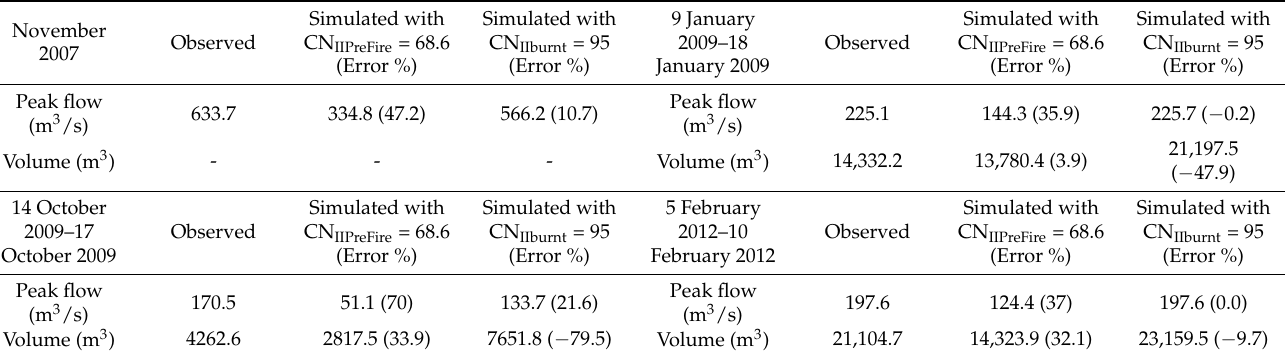
Table 7. Comparison of the observed and simulated peak flow and flood volume for different values of the Curve Number for four flood events (HEC-HMS